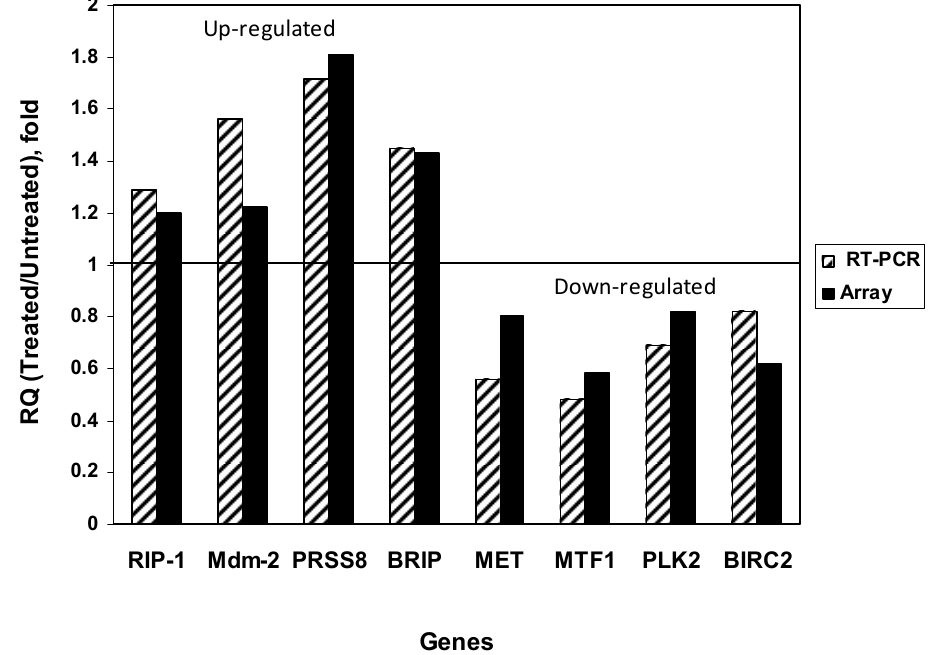
Figure 2. Real-time confirmed and validated differentially expressed up- and down-regulated ( p < 0.05) genes in R2-treated cells versus untreated cells. The fold of RQ treated to untreated ratios is shown for RT-PCR. The bold black bars show average fold of ratios of R2 treated to untreated by microarray analysis and the striped black and white bars show average fold of mRNA levels of gene expression by RT-PCR analysis. Up-regulated and down-regulated genes are marked. The changes are statistically significant, p <